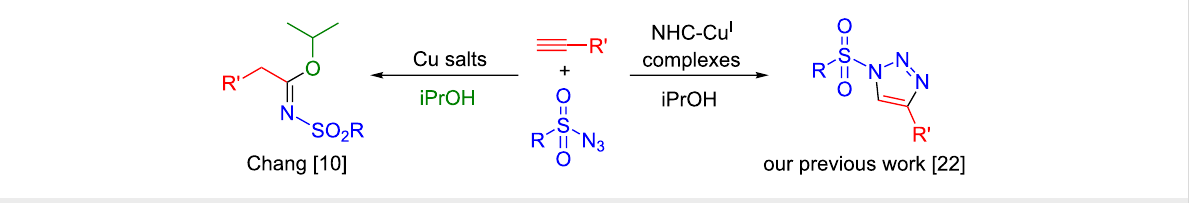
catalysts was investigated in the context of achieving formation of the challenging sulfonamide derivatives. Herein, we report the high efficiency of cationic copper(I) com- plexes for the formation of N -sulfonylamidines via a three-com- ponent reaction performed in air, using solvent-free conditions and in the absence of any